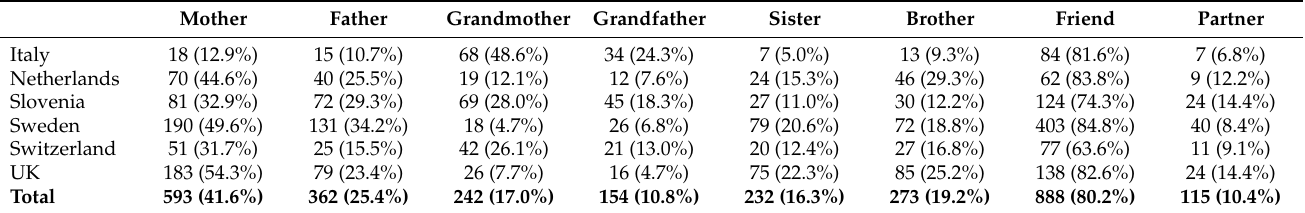
Table 4. Number and proportion of recipients of care indicated by AYCs across the six countries (multiple answers possible per AYC in each country).